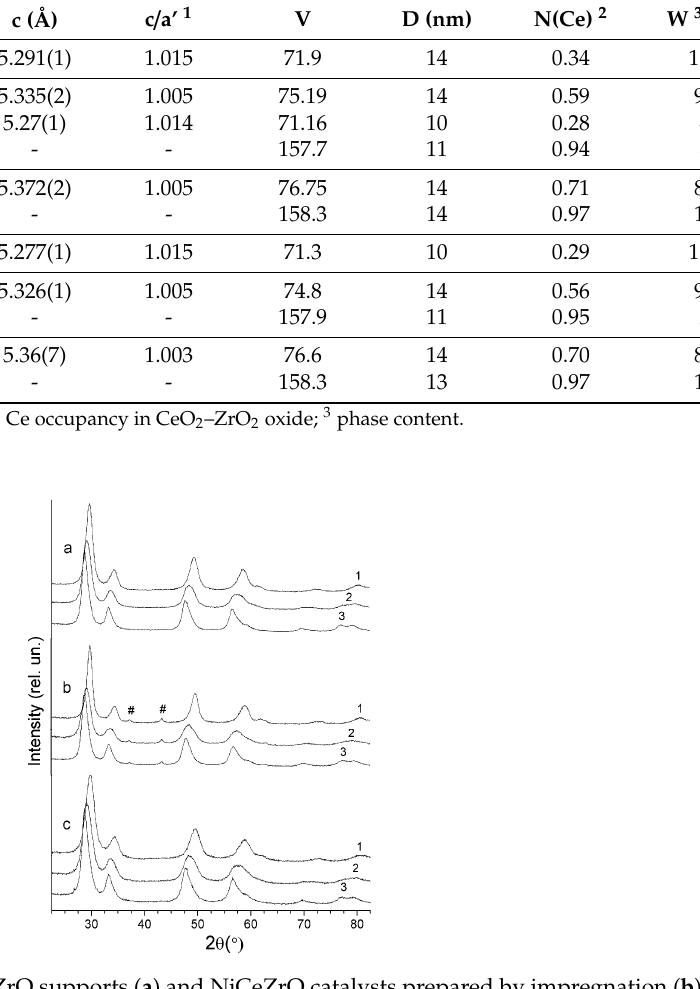
Table 2. Lattice parameters and phase composition of Ce x Zr 1 − x O 2 and Ni-Ce x Zr 1 − x O 2 op samples.